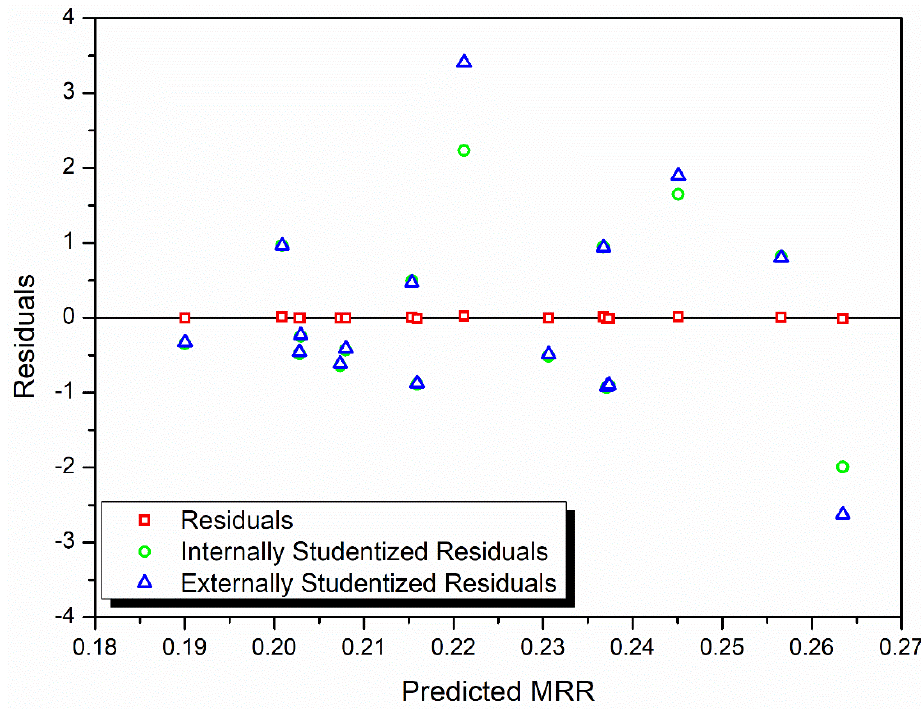
Figure 3. Residuals versus predicted response for MRR.